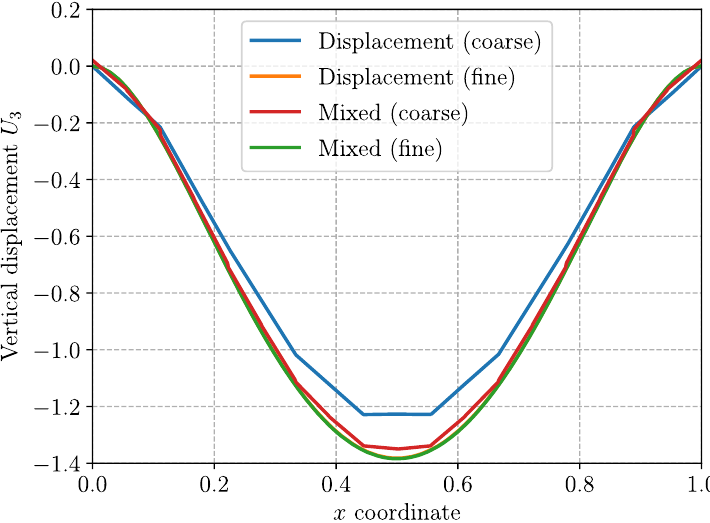
Figure 7. Vertical deflection U 3 [m] for the thin plate case (both solutions in the fine mesh case are